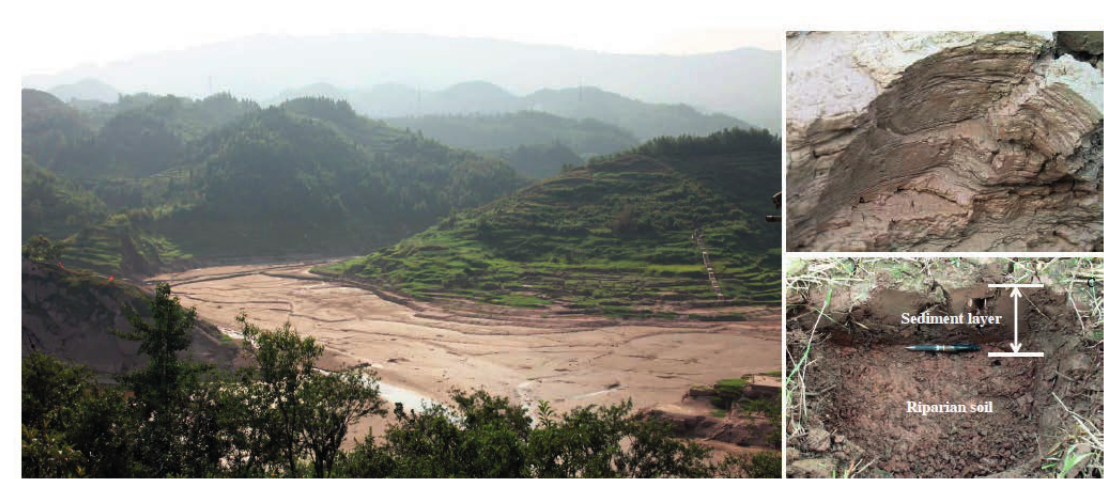
Fig. 2 . A typical view of sedimentation in the riparian zone of the TGR and the sediment–soil boundary in field